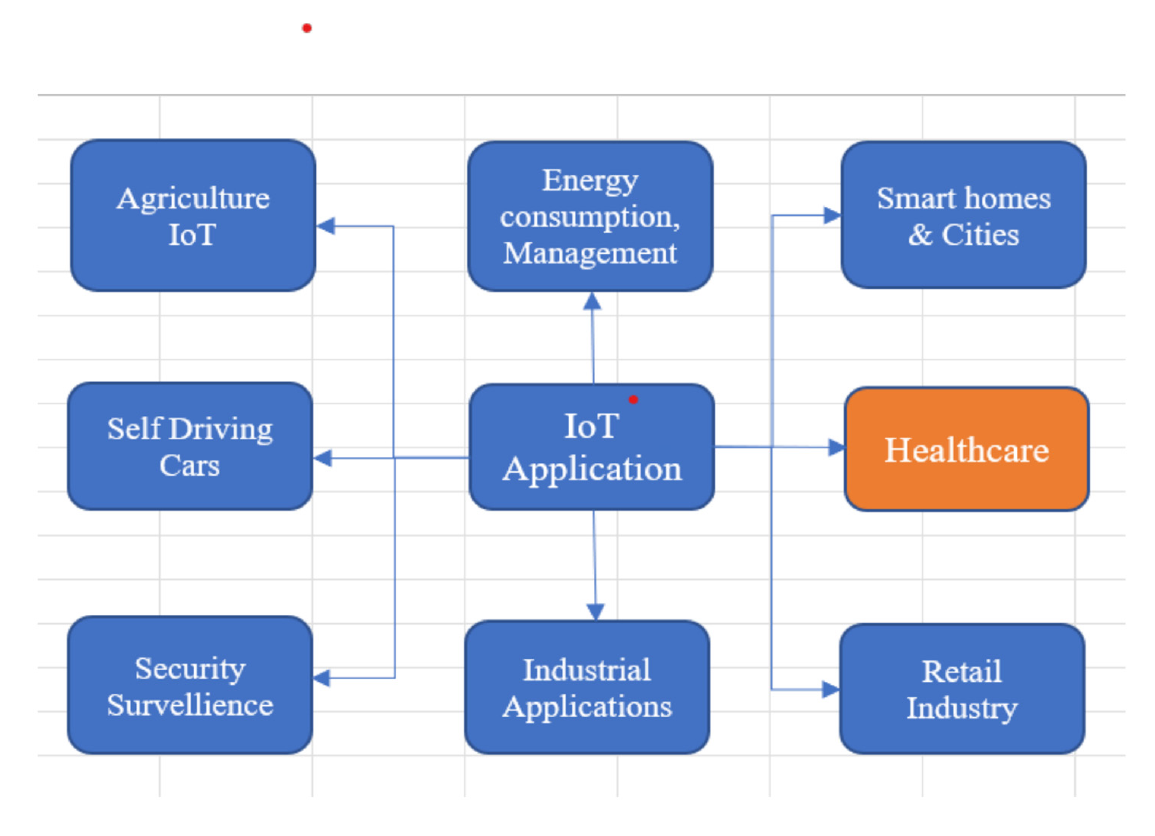
Figure 2. Applications of IoT.